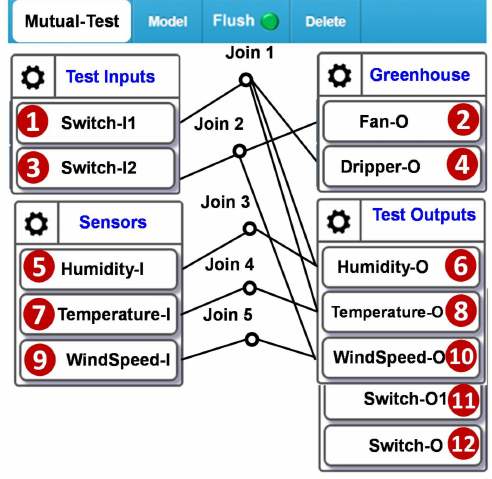
Figure 19. Mutual Test Configuration for the greenhouse.